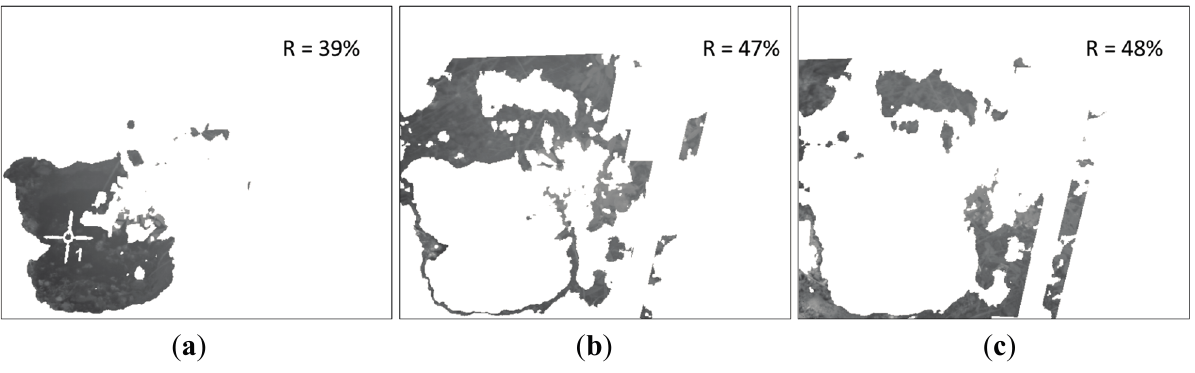
Figure 14. Effective clusters resulting from the K-means procedure. ( a ) First cluster, named C1; ( b ) Second cluster; ( c ) Third cluster.